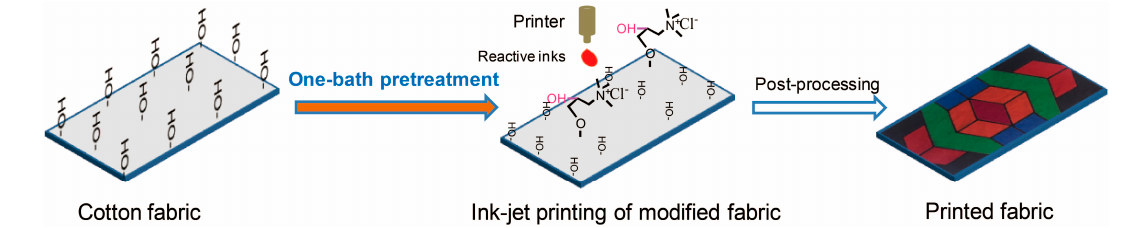
Figure 1. Flowchart of ink-jet printing on modified cotton.